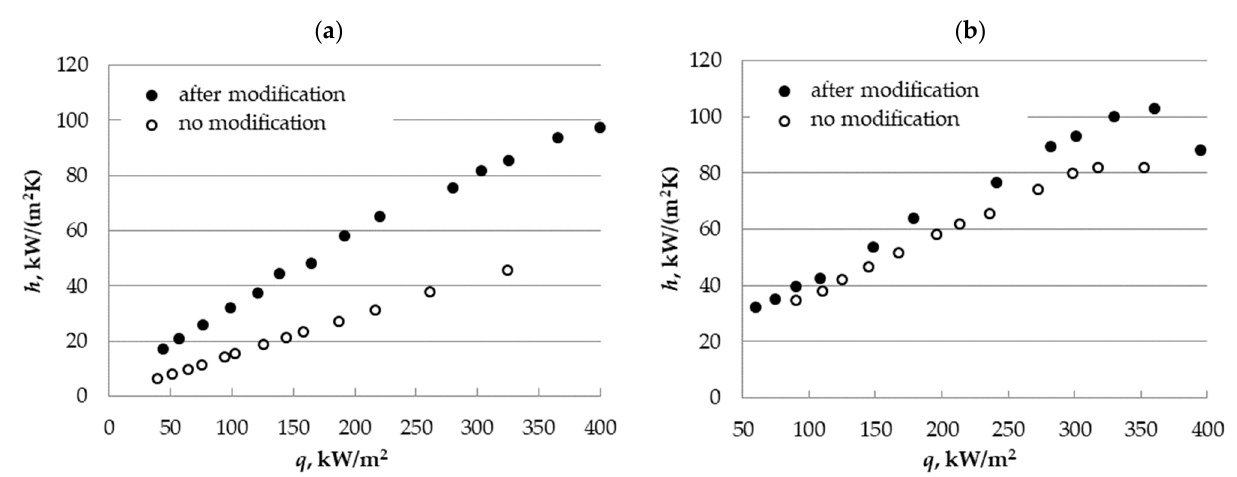
p r = 0.43, ( b ) p r = 0.56.